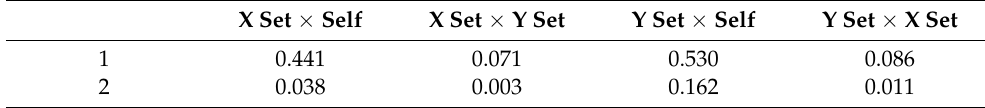
Table 6. Redundancy analysis for canonical correlation